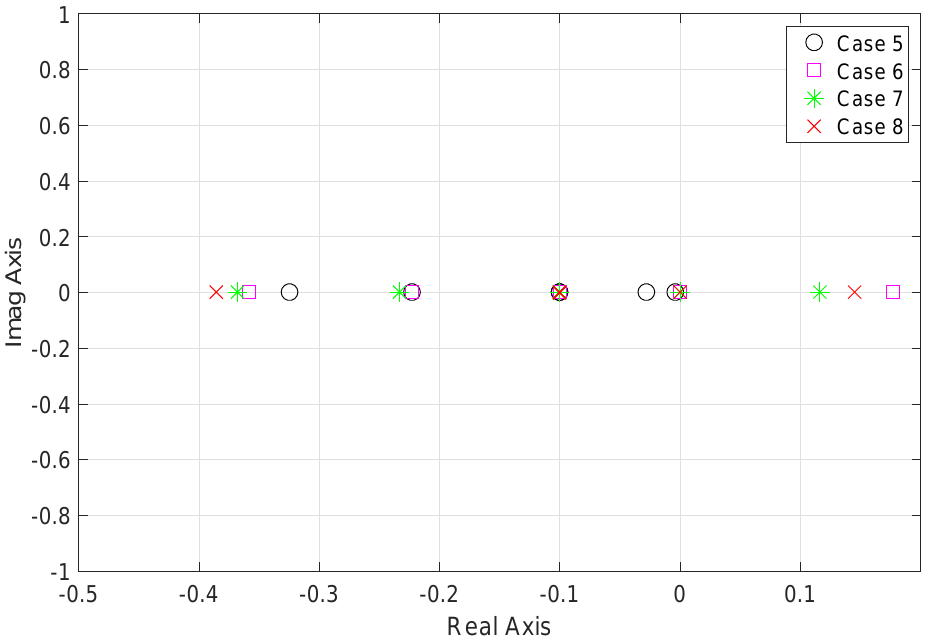
Figure 9. Eigenvalues resulting from the modeling of the case with a 45% increased load.